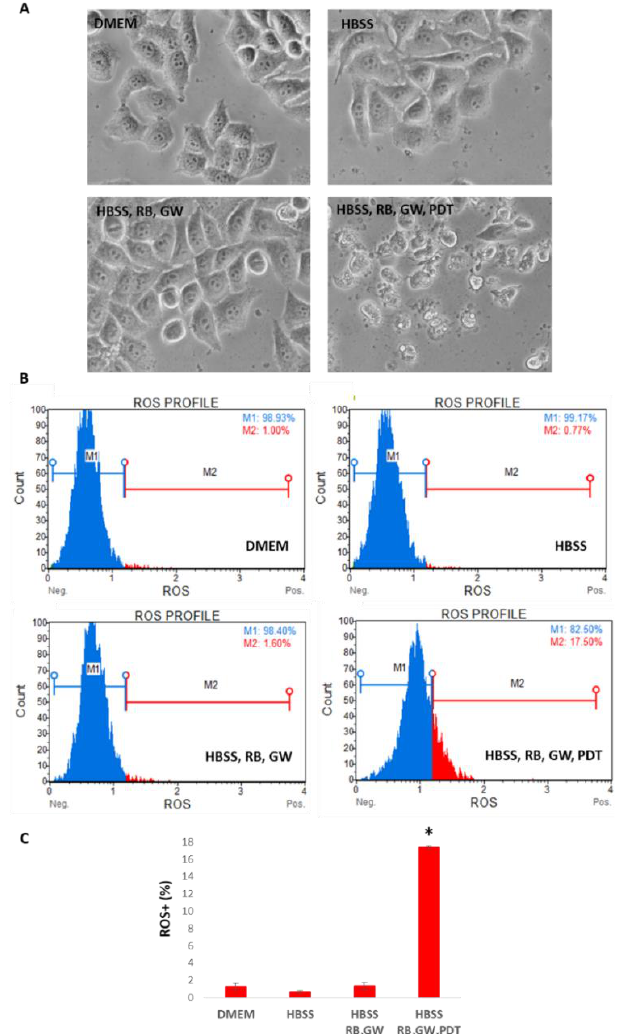
Figure 12. Oxidative stress analysis of T98G cells following RB starvation, PDT exposition and GW4869 administration scheme. Cells were grown in standard DMEM high-glucose medium, starved for 30 min in HBSS media, treated with RB (0.75 µ M) and GW4869 (GW = 5 µ M), and exposed or not to PDT (2 min at 562/576 nm). ( A ) Cells were visualized using optical microscope at 20 × magnification (Nikon Eclipse TS100). ( B ) Trypsinized cells were finally analyzed after 24 h p.t. in standard growing media for ROS + production using the Guava Muse Oxidative Stress kit (Luminex). ( C ) The histogram of percentages of ROS + (i.e., M2 gates) events of two independent experiments is reported ( n = 3000 each). Asterisk indicated statistical significance comparing HBSS, RB, GW and PDT-exposed cells to the other samples ( p < 0.05, ANOVA one-way; SD are highlighted as vertical bars). M1 and M2 gates, respectively for ROS − and ROS + events, were established on untreated cells in DMEM high-glucose standard growing condition and adopted for all samples.